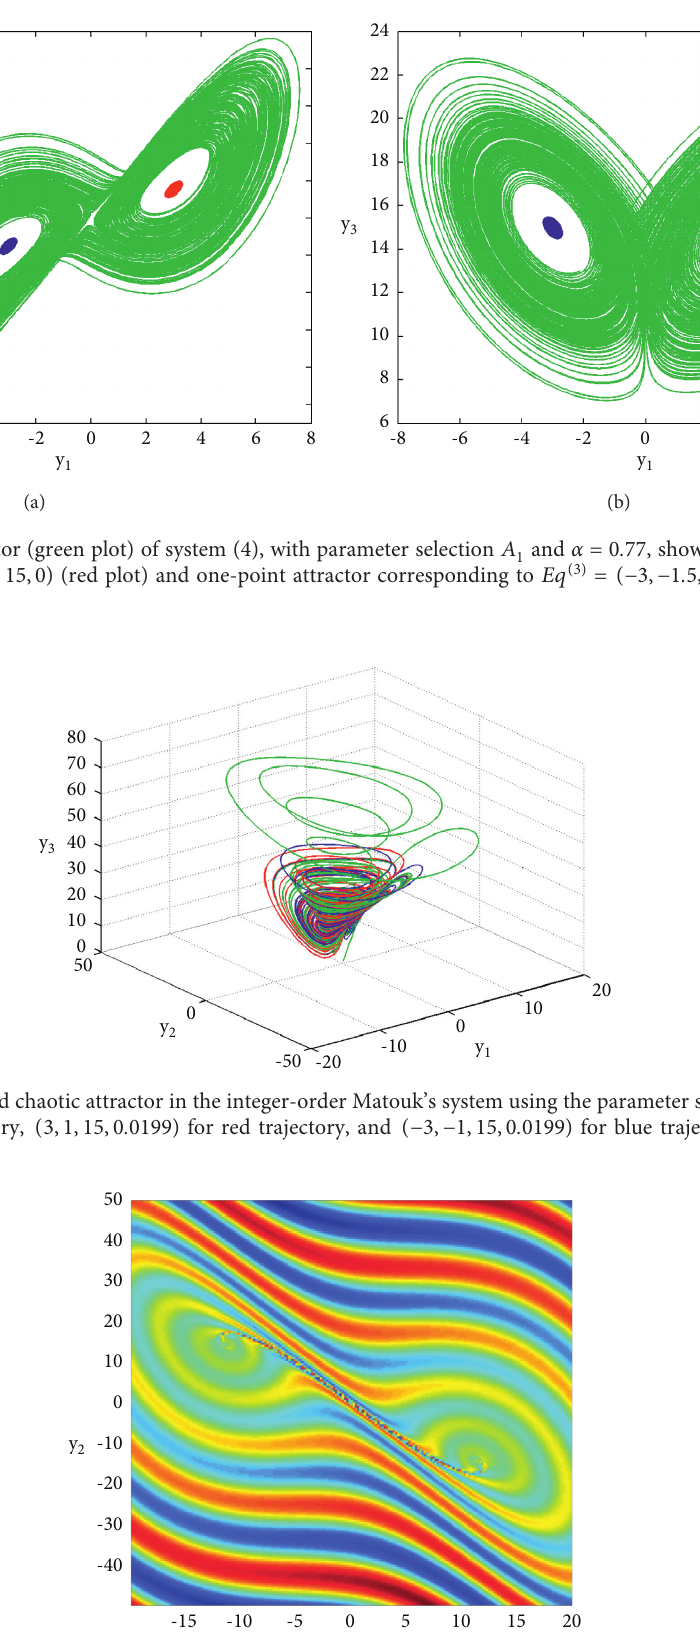
� 0and y � 0 of basins of attraction for the self-excited attractor. 3 4